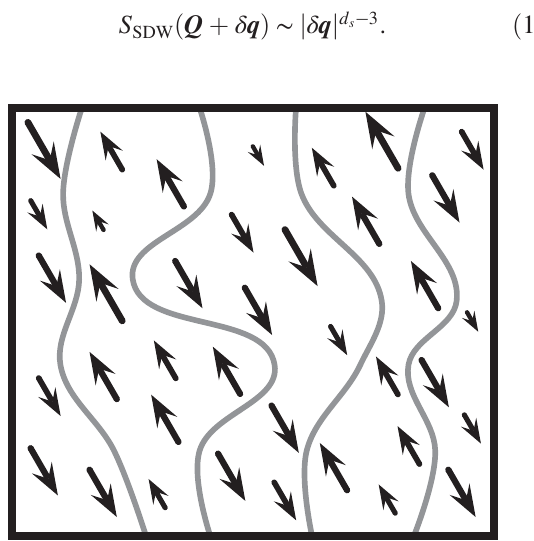
FIG. 3. In the SDW Bragg glass, the antiphase domain walls are pinned in a configuration without